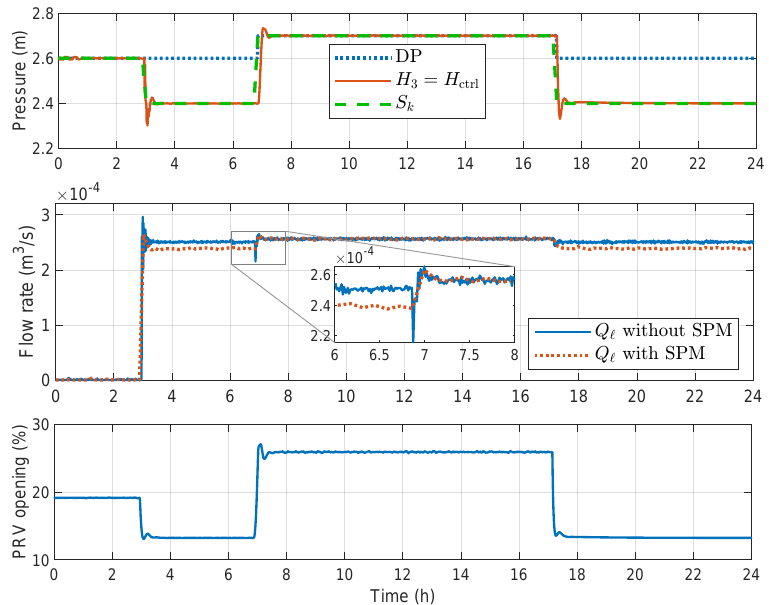
Figure 7. Case 1: Pressure control and management in a pipeline with a leak before the con- trolled